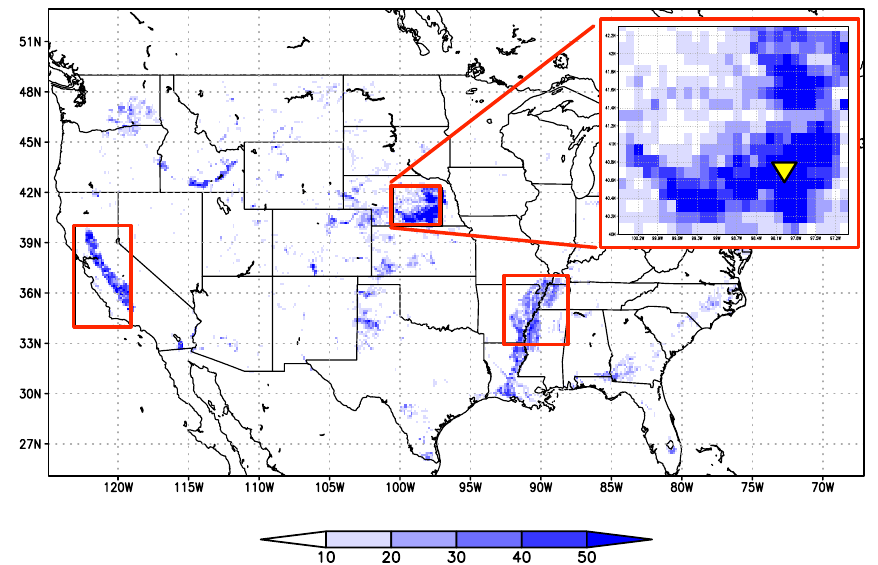
Figure 1. MODIS-based irrigated grid-cell fraction (%) map of Ozdogan and Gutman (2008) over the continental US. The boxes (outlined in red color) highlight three known areas with large-scale seasonal irrigation. The yellow triangle in the inset indicates the location of the grid cell used in point-scale land surface model simulations.